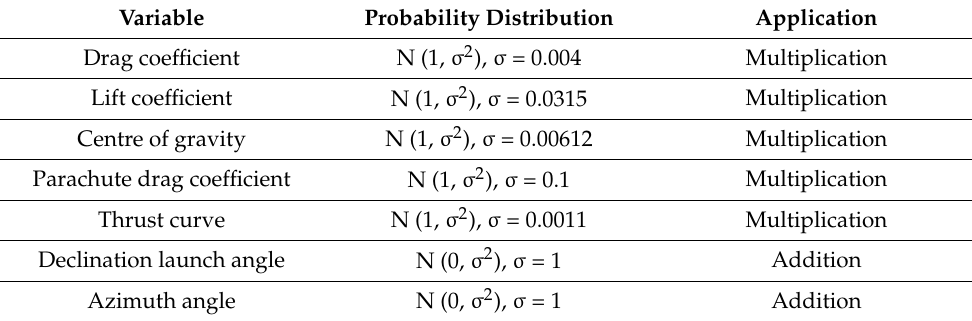
Table 6. Monte Carlo Coefficient